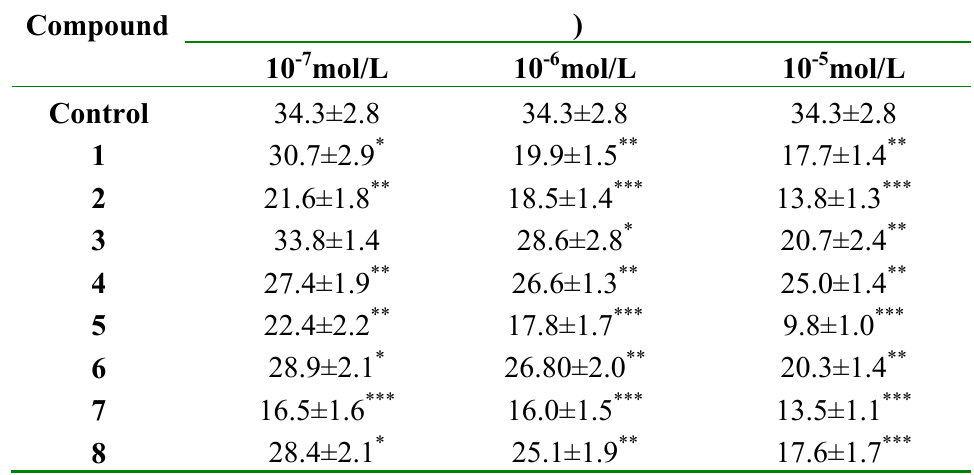
Table 3. Effects of compound 1-8 on osteoclast TRAP activity induced from rat marrow cells (n=8,